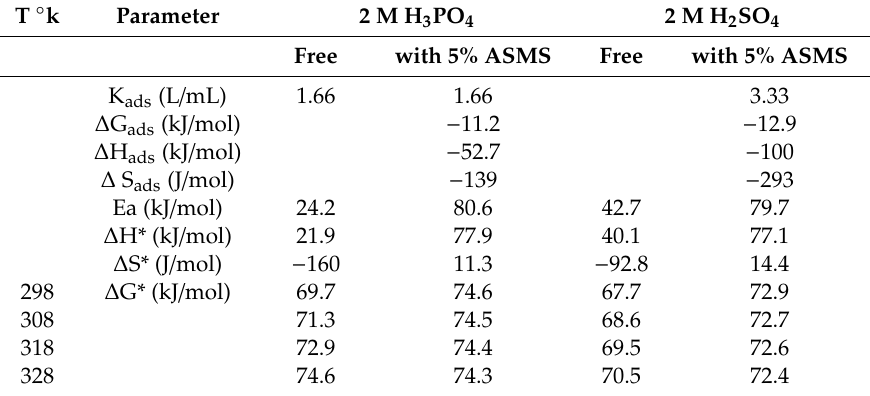
Table 3. Adsorption and activation thermodynamic parameters in the presence of a 5% concentration of